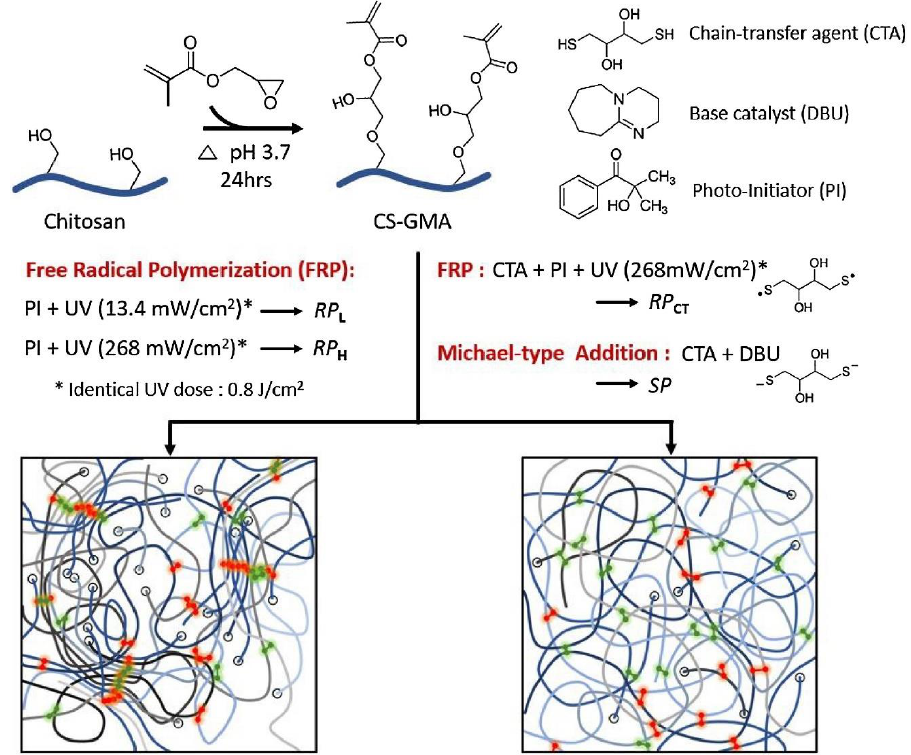
Figure 7. Synthetic routes for chitosan hydrogel preparation and schematic illustrations of the expected network structures of RP L (radical polymerization at low UV intensity) and RP H ( left ) radical polymerization at high UV intensity) or RP CT (chain-transfer radical polymerization) and SP (step polymerization) ( right ). Open circles represent the point at which the chain moves out of the plane. Red and green linkages indicate inter- and intra-chain crosslinking, respectively [88] .